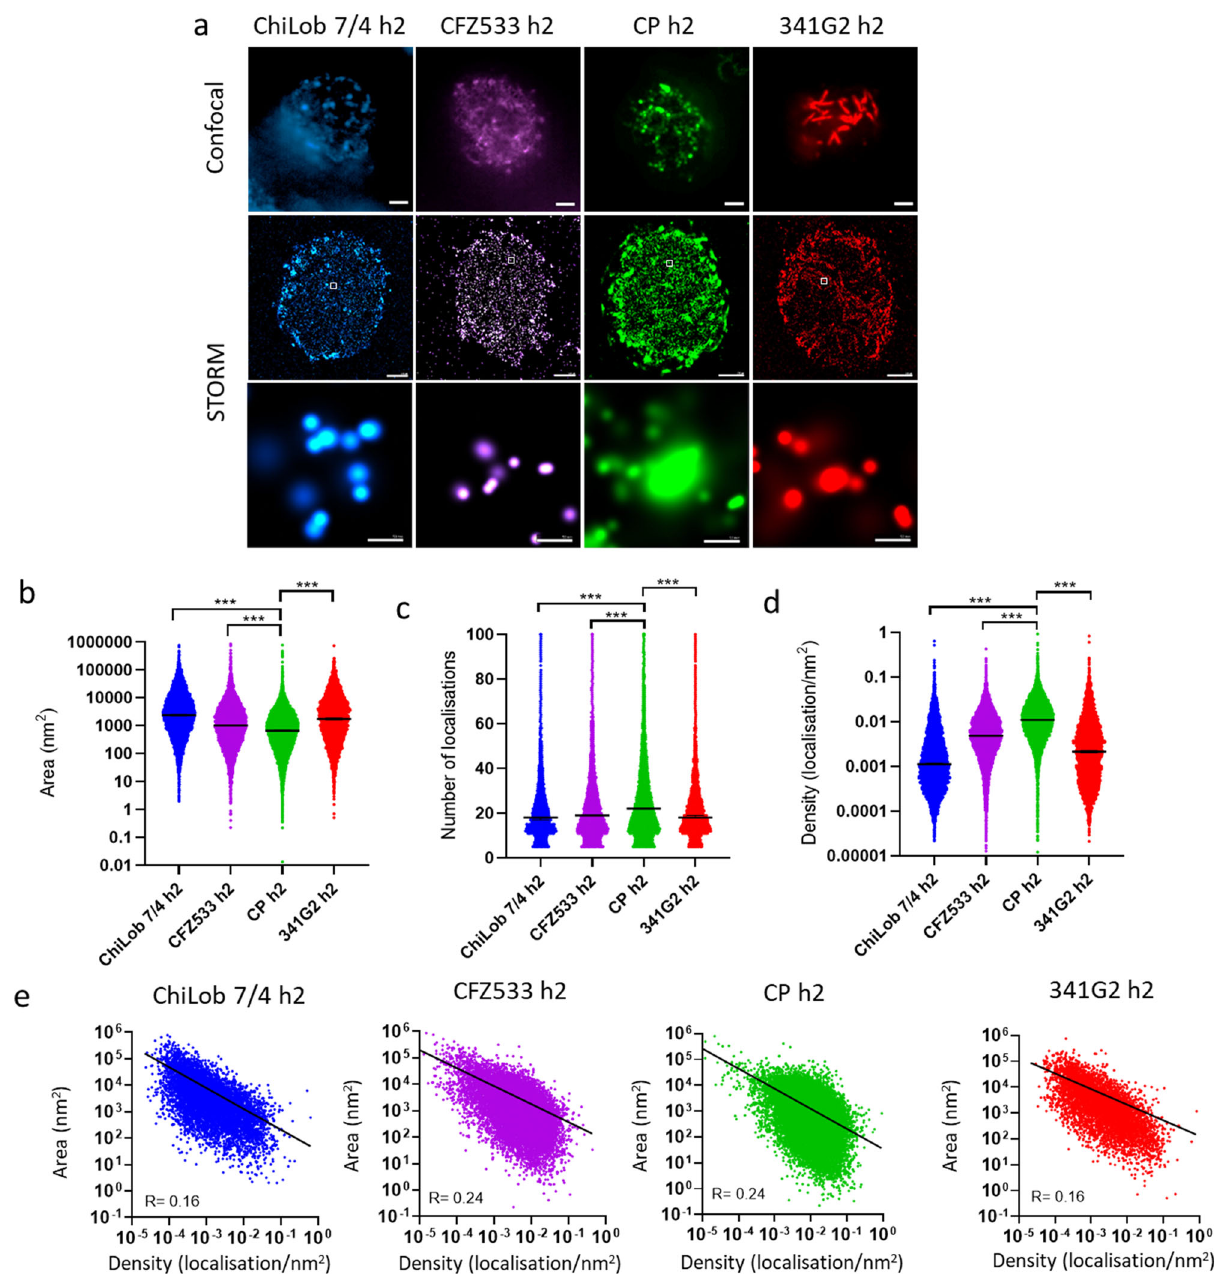
Fig. 3 STORM assessment of differential CD40 clustering induced by a range of CD40 agonists. Jurkat cells expressing hCD40ECD-GFP were incubated with 50 µ g/mL AF647-labelled anti-CD40 mAb at 37 °C for 1 h and then washed and fi xed with 4% PFA. Cells were imaged using an ONI Nanoimager. a Representative confocal images (upper panel; scale bar, 2 µ m), STORM images (middle panel; scale bar, 2 µ m) and zoomed-in STORM image showing localisation patterns (lower panel; scale bar, 50 nm). Comparison of b area, c number of localisations and d density of clusters induced by various anti-CD40 mAbs as indicated, calculated by NimOS v1.6 software. Two-tailed, non-paired Student t test, * p < 0.05, ** p < 0.01, *** p < 0.001. e Correlation between area and density of clusters induced by various anti-CD40 mAbs as indicated. Data are representative of three independent